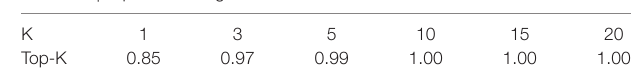
TaBle 2 | Top-K matching rate for the solo-based